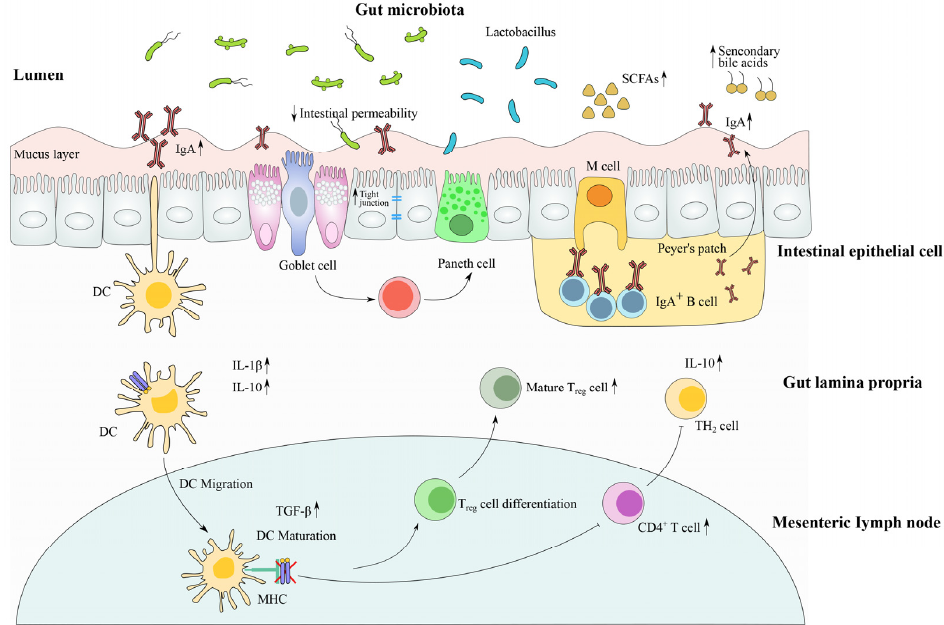
Figure 3. The molecular mechanism of Lactobacillus strains in antibiotic-induced dysbiosis.